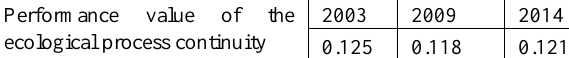
Figure 5. Analysis of Spatial dynamic changes of Ecological performance in Guyuan City from 2003 to